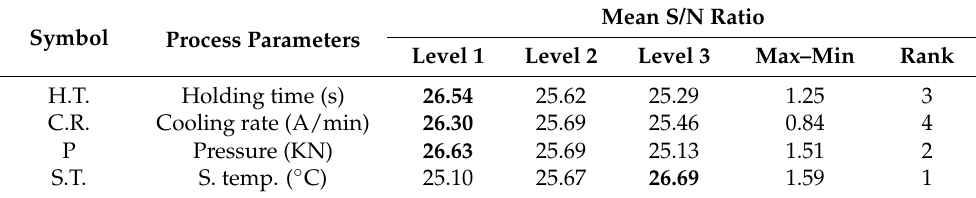
Table 5. Mean S/N ratio response table for Mr (cid:107)